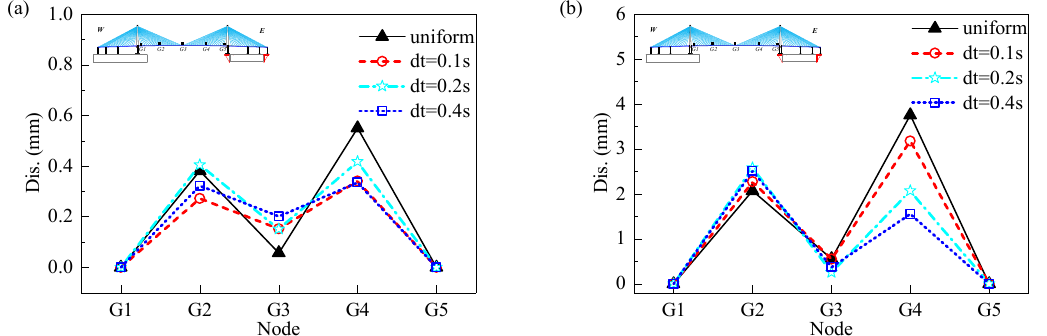
Figure 27. The maximum vertical